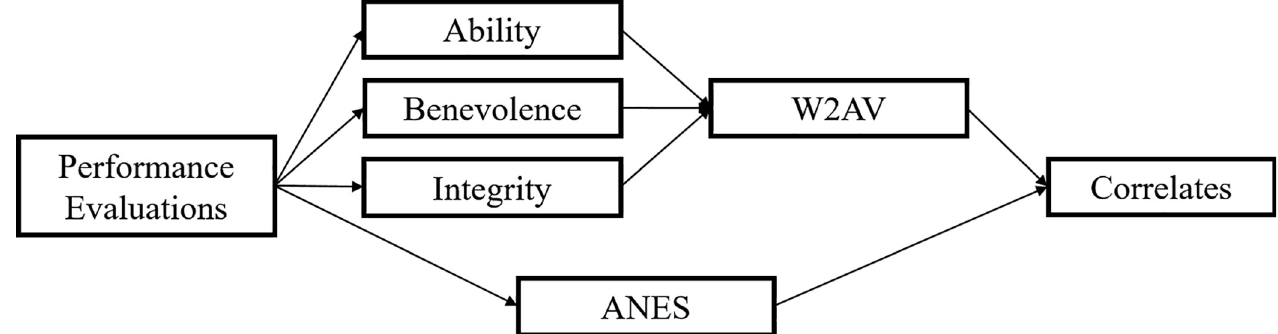
Fig 1. Study hypotheses. Unidirectional arrows indicate regression paths.